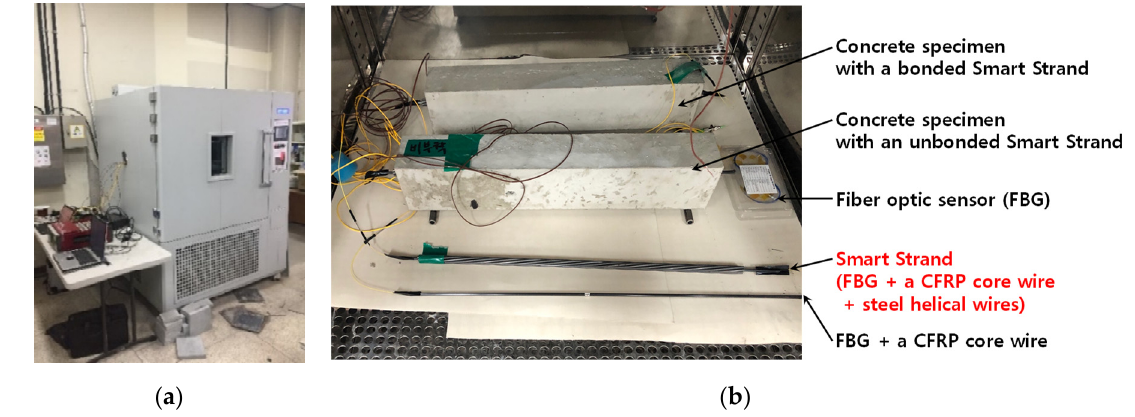
Figure 4. Chamber test: ( a ) temperature-controlled chamber; and ( b ) various specimens.